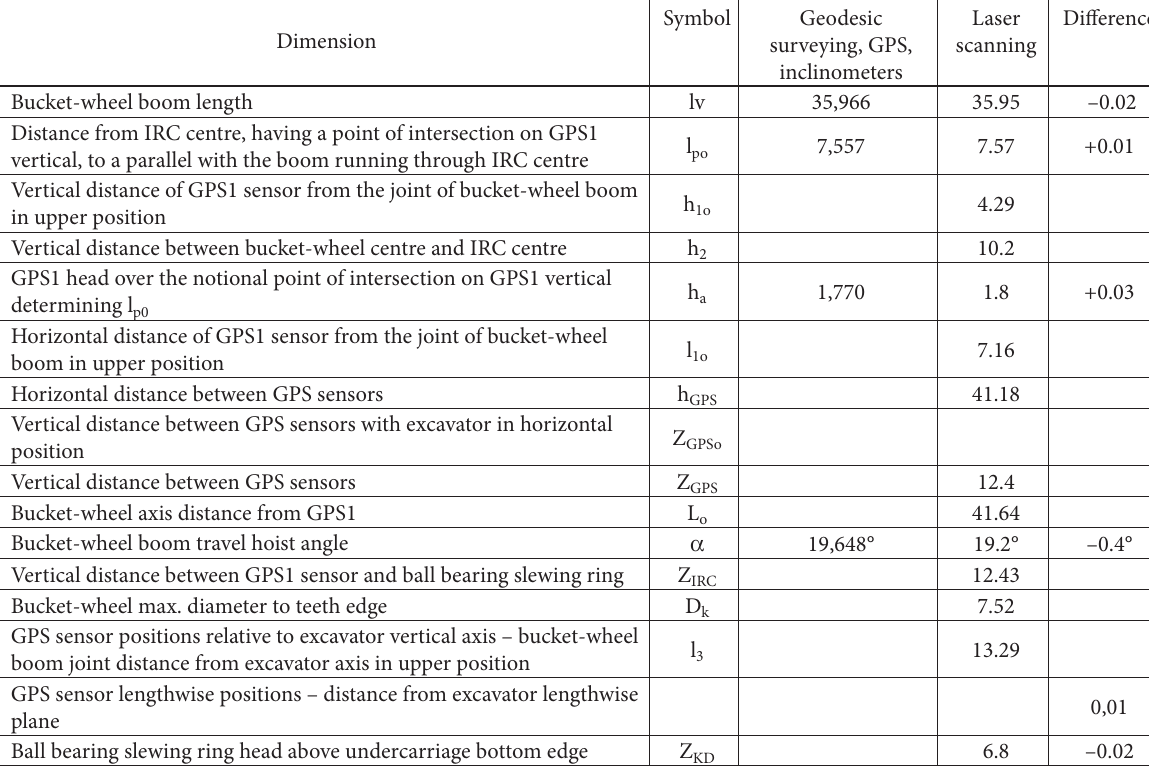
Fig. 5. Bucket-wheel excavator vector model Table 1. K800/N1/103 bucket-wheel excavator geometric parameters, in